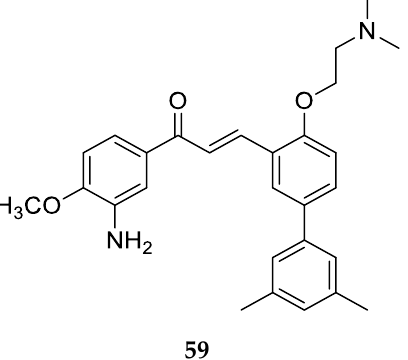
Figure 33. Chemical structures of the 3-aminochalcone derivative with substitution on ring B.